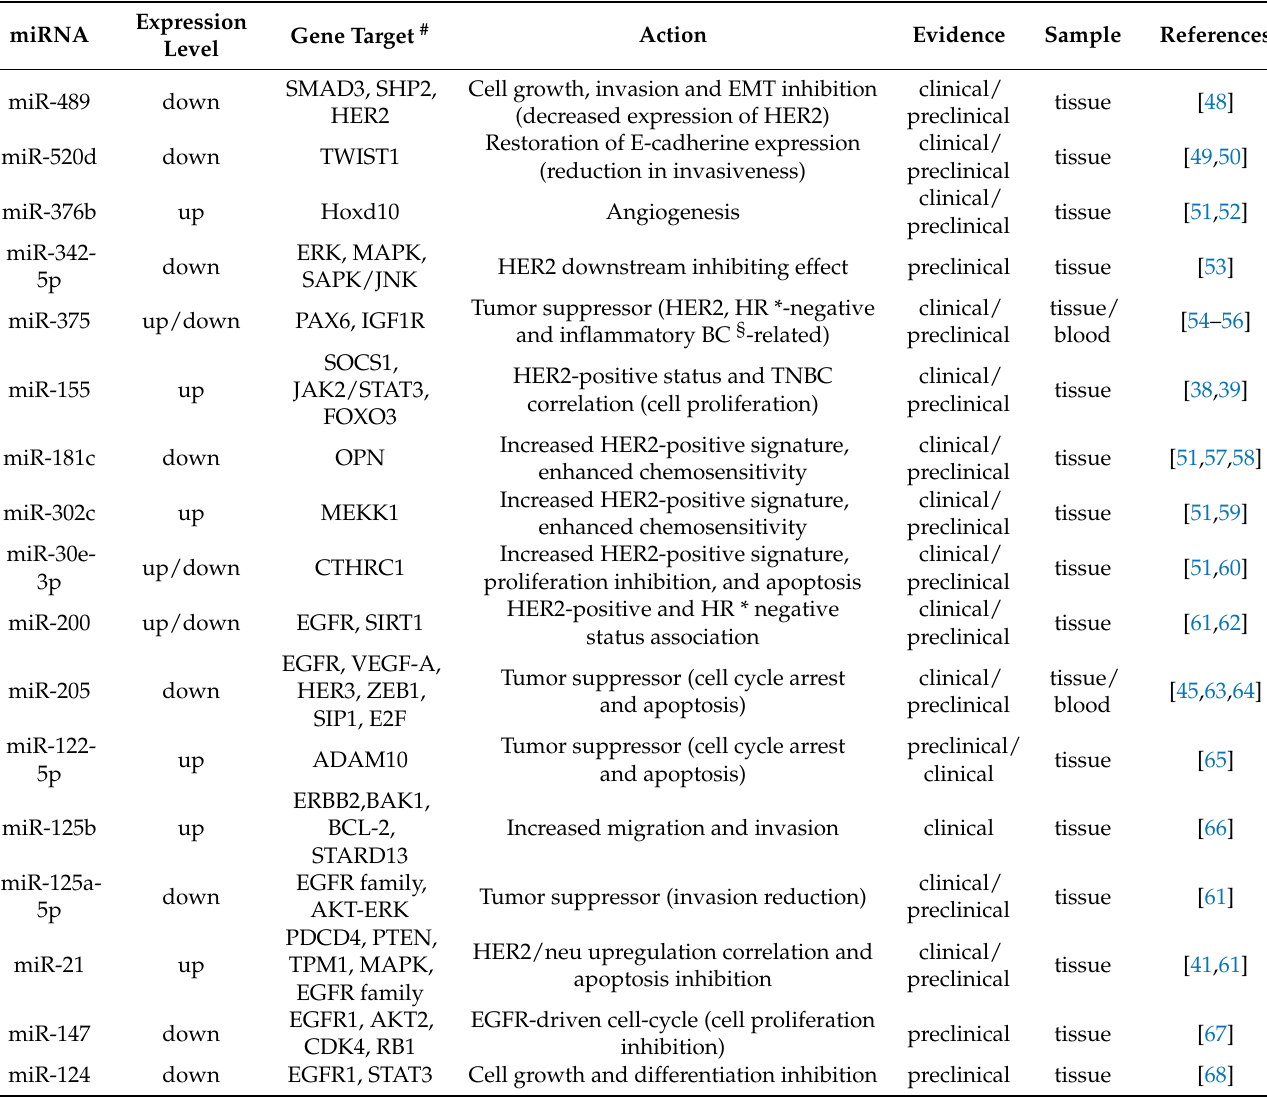
Table 1. HER2-positive breast cancer miRNA